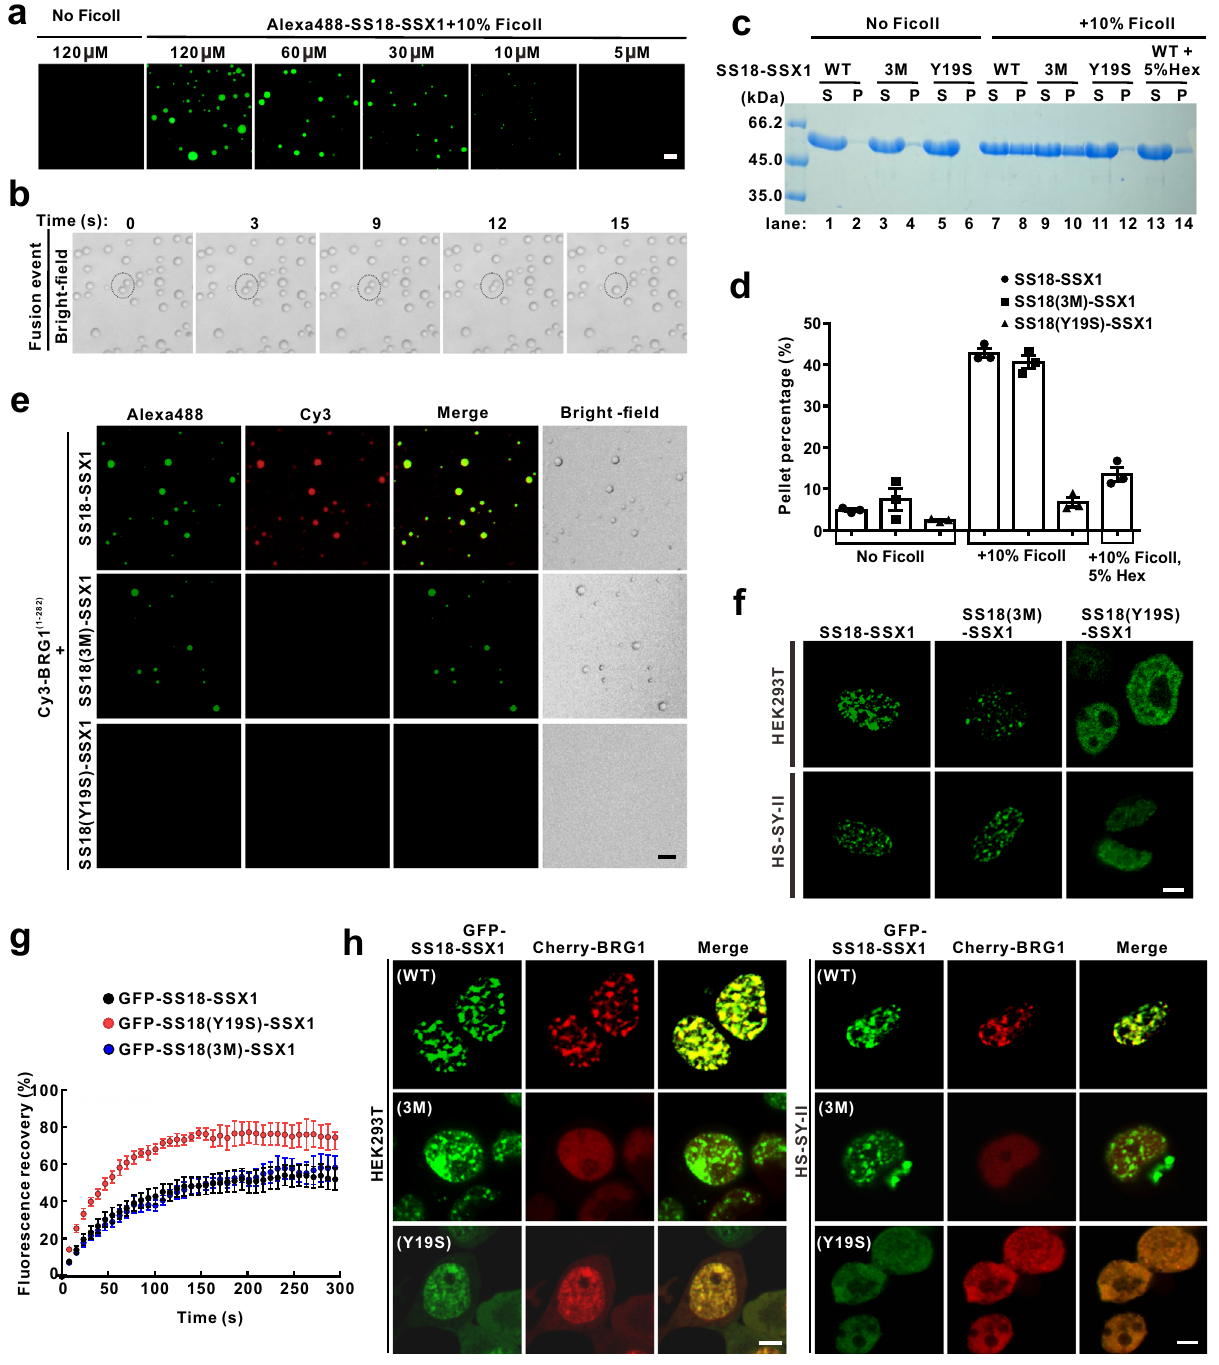
Fig. 5 SS18-SSX1 undergoes LLPS and recruits BRG1 into condensates. a Representative fl uorescence images of the fusion protein SS18-SSX1 at different protein concentrations. Liquid droplets are enriched in Alexa Fluor 488-labeled SS18-SSX1. The droplet formation buffer comprises 50 mM Tris-HCl pH 7.5, 150 mM NaCl, and 10% Ficoll. The scale bars indicate 10 µ m. b Phase-contrast imaging of SS18-SSX1 protein at different time points to show the dynamic fusion of two droplets. Representative SDS-PAGE analysis ( c ) and quantitative data ( d ) of the sedimentation assay of SS18-SSX1 protein or mutants in the buffer with or without 10% Ficoll. 1,6-hexanediol (Hex, 5%) was added to the SS18-SSX1 protein to disrupt droplet formation. The concentration of each protein is 60 µ M. The band intensities of proteins were quanti fi ed with Image J v1.8.0 software. The statistical data represent results from three independent batches of sedimentation experiments and were plotted as mean ± SEM. e Representative fl uorescence and bright- fi eld images of the mixture of Alexa Fluor 488-labeled SS18-SSX1 or mutants (60 µ M) and Cy3-labeled BRG1 (1-282) (60 µ M) in the buffer comprised 50 mM Tris-HCl pH 7.5, 150 mM NaCl, and 10% Ficoll at room temperature. The scale bar indicates 10 μ m. f Live-cell imaging for GFP-SS18-SSX1, GFP-SS18(3M)-SSX1, and GFP- SS18(Y19S)-SSX1 in HEK293T and HS-SY-II cells. The scale bar indicates 5 μ m. g FRAP recovery curves for GFP-SS18-SSX1, GFP-SS18(3M)-SSX1, and GFP- SS18(Y19S)-SSX1 puncta from three independent HeLa cells with error bars indicating mean ± SEM. Time 0 refers to the time point of the photobleaching pulse. h Co-expression of GFP-SS18-SSX1 or mutants and Cherry-BRG1 in HEK293T and HS-SY-II cells. The scale bar indicates 5 μ